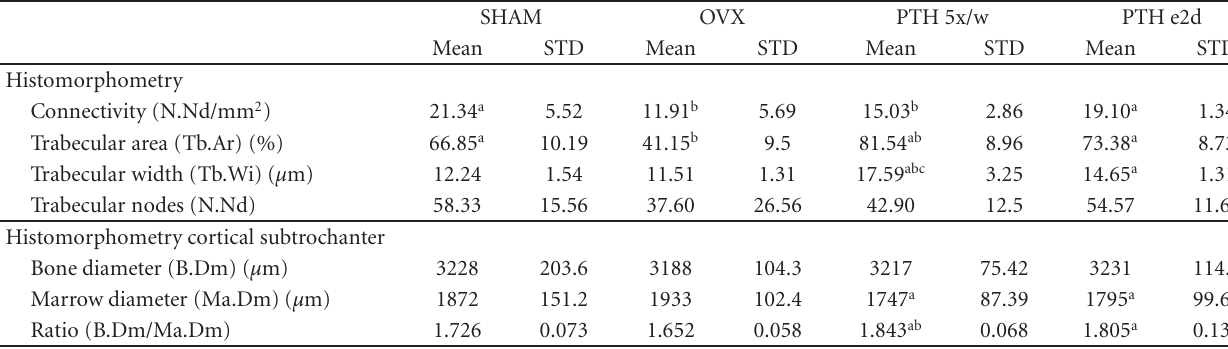
Table 2: Results of the histomorphometry